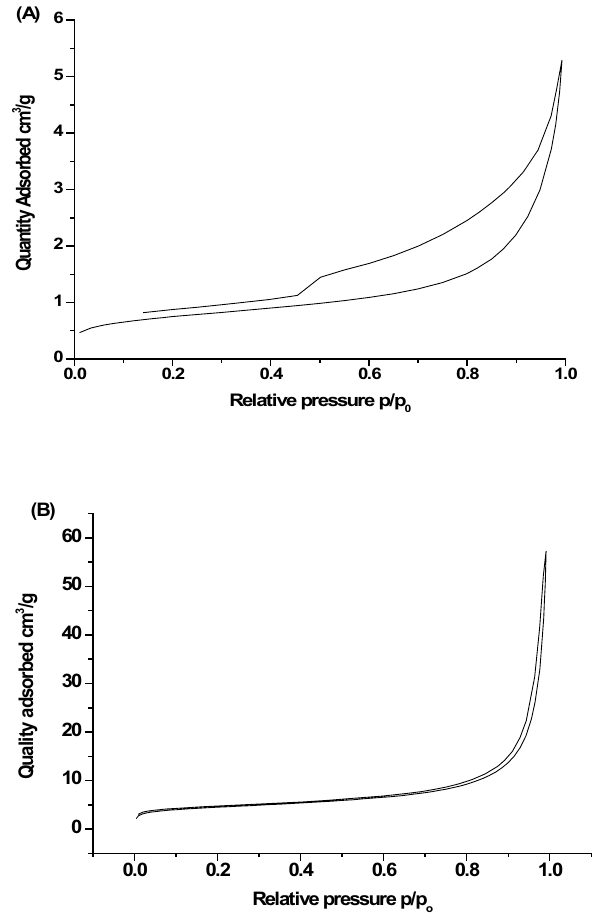
Fig. 6 Nitrogen adsorption–desorption isotherms as per BET equa- tion for A MVPA and B MVPA/Kaolin